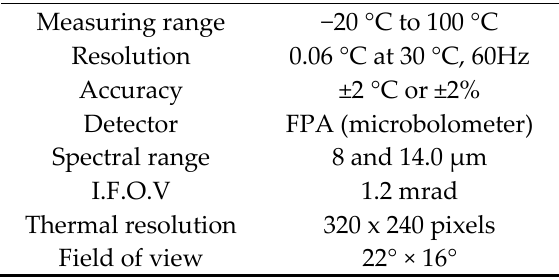
Table 2. Main specifications of the IR